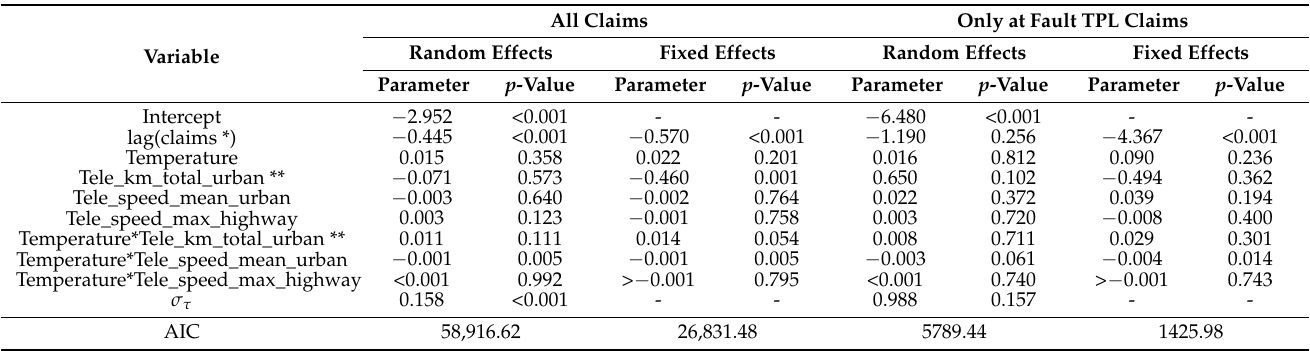
Table A12. Cross-table with the parameter estimates of random effects and fixed-effects Poisson panel data models, with p -values, for the total number of claims (left) and at-fault third party liability (TPL) claims (right) per month and per insured based on the seven observed months in 2018 and 2019. The models consider the average monthly temperature as explanatory variable describing weather conditions. Interactions are